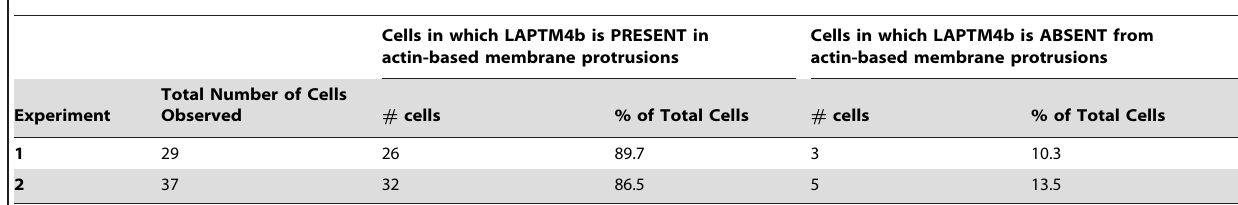
Table 1. mCh-LAPTM4b co-stains with membrane-protrusions when overexpressed in Hek293T cells.